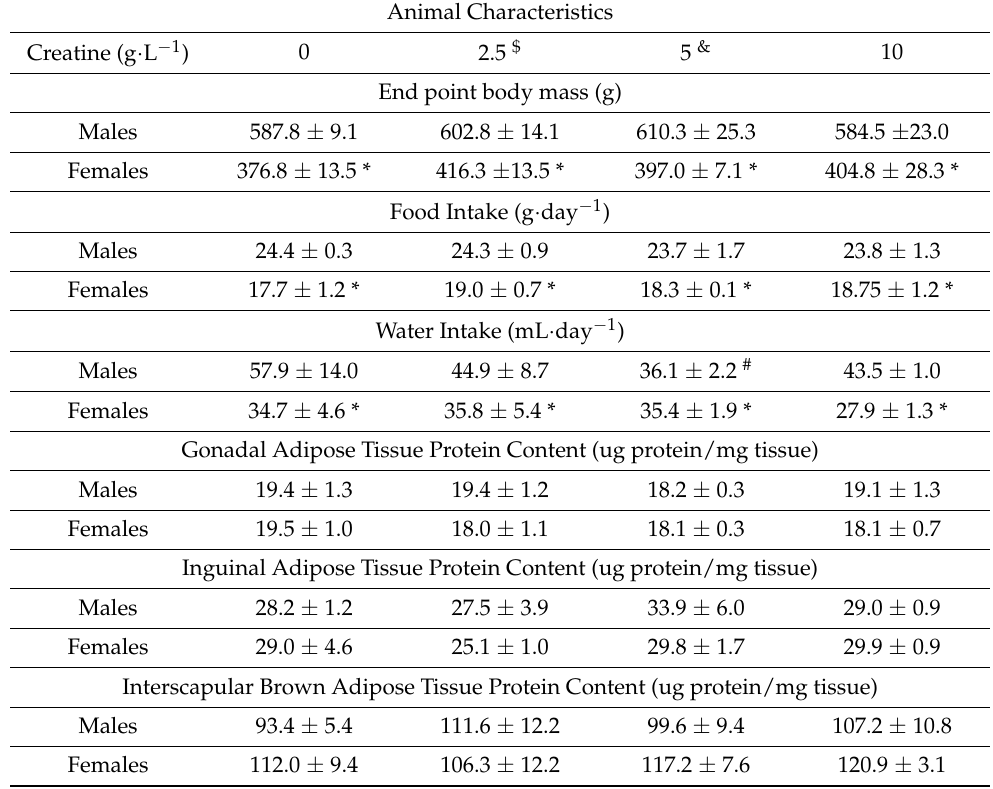
Table 1. Animal and adipose depot